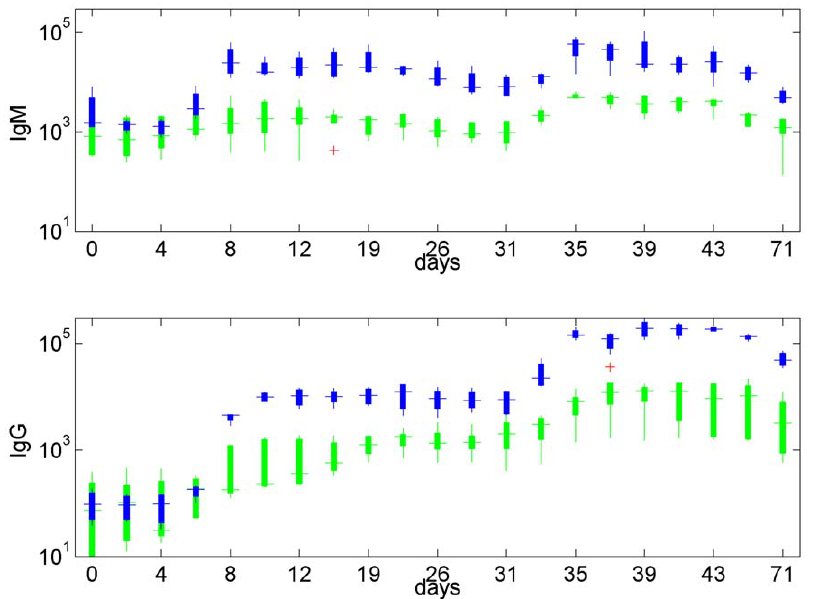
Figure 6. In-vivo experimental results for cattle inoculated with a regular dose of vaccine at 0 and 29 days, giving the resultant IgM (left) and IgG (right) levels recorded: (top: blue) normal vaccine producing a regular immune response; (bottom: green) vaccine stimulating the T-cell independent response only. Plots give the median value (central bar), 25th–75th percentile (box) and extreme values (whiskers) unless considered outliers, in which case they are plotted separately (cross) for four (bottom: T-cell independent) or five (top: T-cell dependent) replicates (individual cattle). Data from [9]. Note the significant differences in magnitude between the T-cell dependent and T-cell independent cases. Results presented on a log-scale.